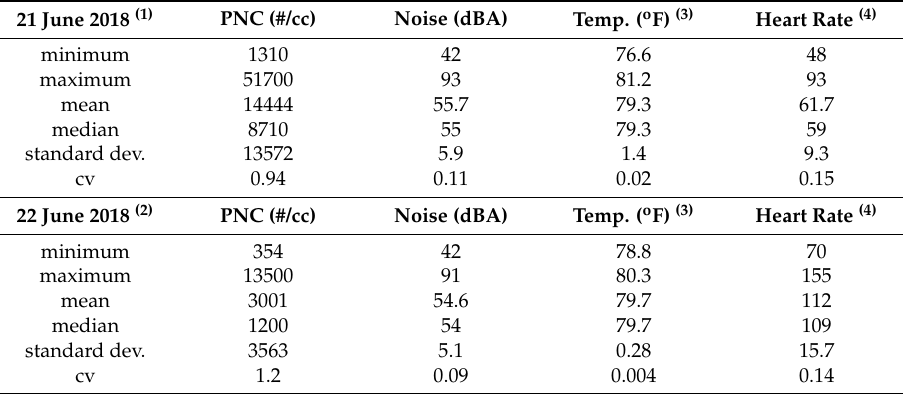
Table 2. Descriptive statistics for participant # 300041.